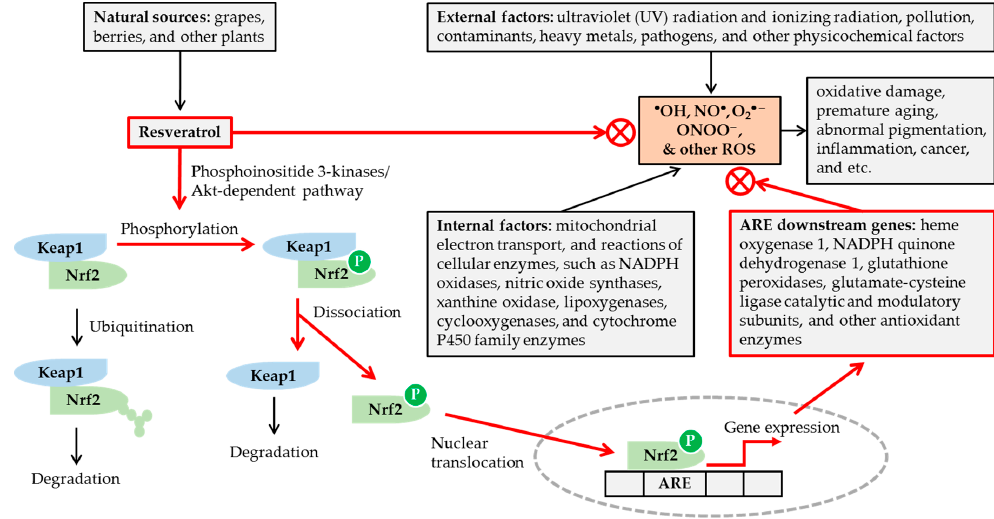
Figure 1. Potential mechanisms for the antioxidant action of resveratrol. Various internal and external factors can cause oxidative stress by increasing the formation of reactive oxygen species (ROS) in excess of cellular antioxidant capacity. Resveratrol, available from various natural sources, can attenuate the oxidative stress, by scavenging ROS, and/or enhancing cellular antioxidant capacity via nuclear factor erythroid 2-related factor 2 (Nrf2)-mediated mechanisms. Resveratrol stimulates phosphorylation of Nrf2 by a phosphoinositide 3-kinases/Akt (protein kinase B)-dependent mechanism, and releases Nrf2 from Kelch-like ECH-associated protein 1 (Keap1). The nuclear translocation of Nrf2 leads to the activation of antioxidant response elements (ARE) linked to gene expression of many cellular antioxidant enzymes. In this way, resveratrol can reduce oxidative damage, premature skin aging, abnormal pigmentation, and other age-related